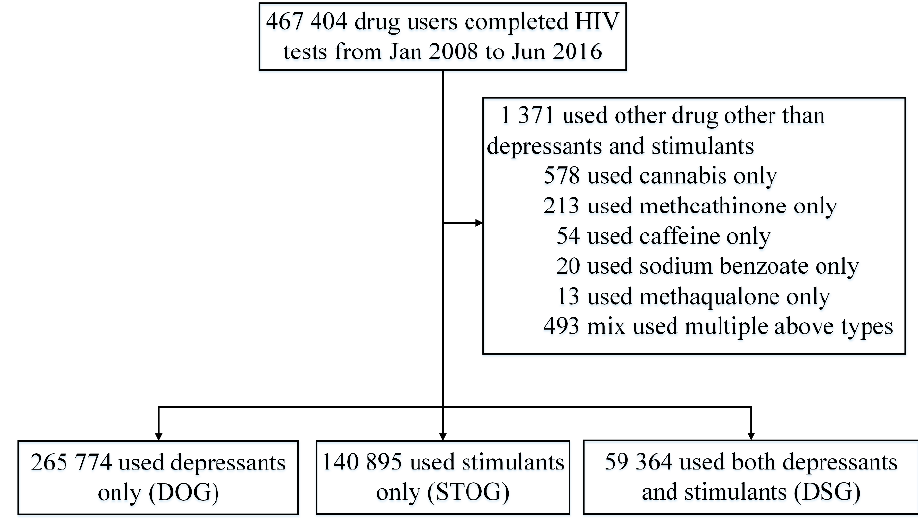
Figure 1. Group classification. Table 1. Characteristics of depressants only users, stimulants only users and both depressants and stimulants users in China, 2008–2016.